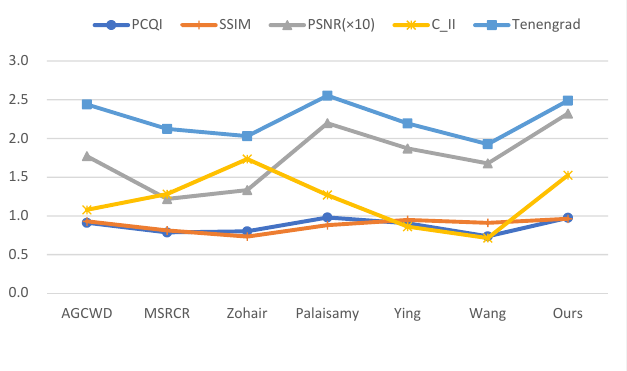
Figure 12. Average index comparison chart, each algorithm corresponds to the average of the five metrics (50 images), and the specific value magnitudes are described in the Ave column of Table 1.